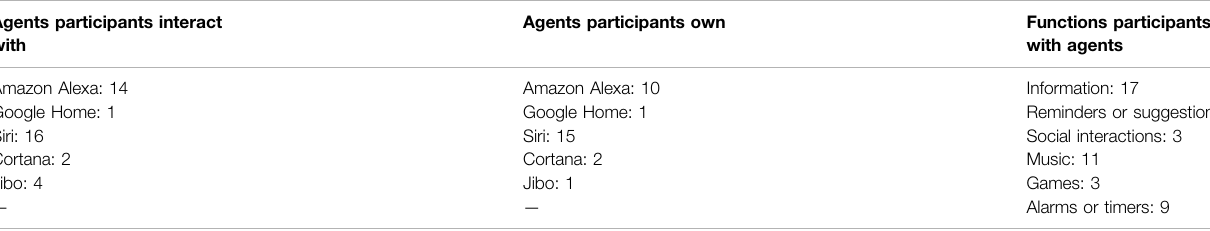
TABLE 1 | Demographics related to agent usage and